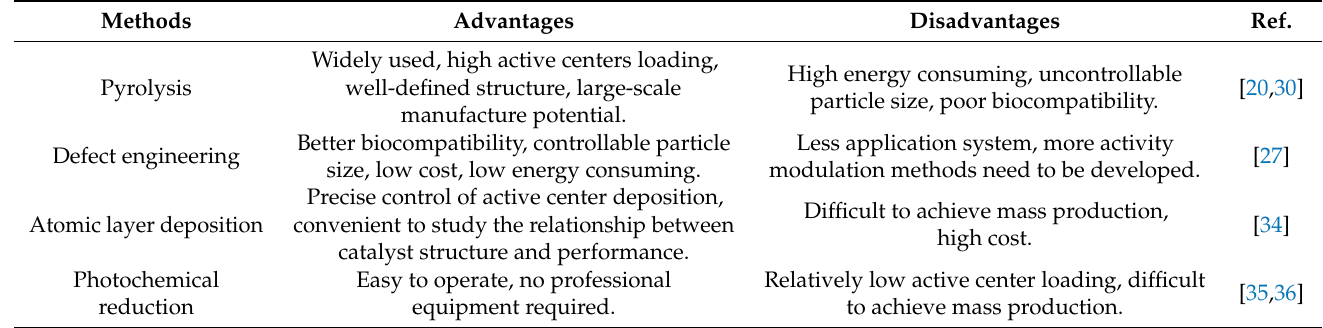
Table 1. Advantages and disadvantages of preparation methods of